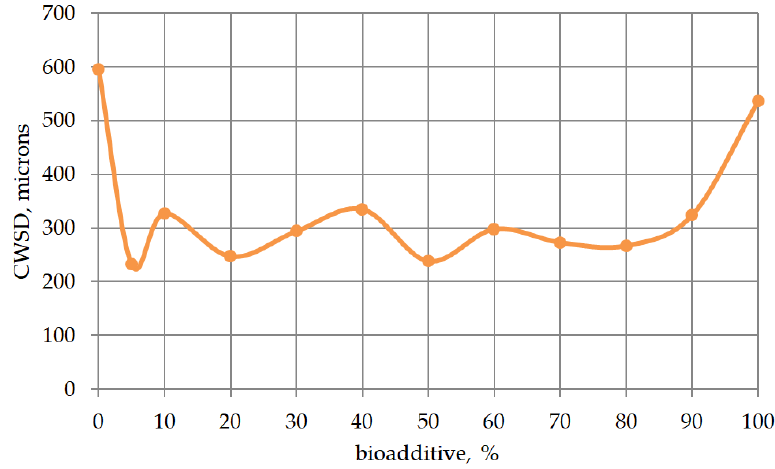
Figure 4. Dependence of lubricity on the content of bio-additives in the green diesel fuel.